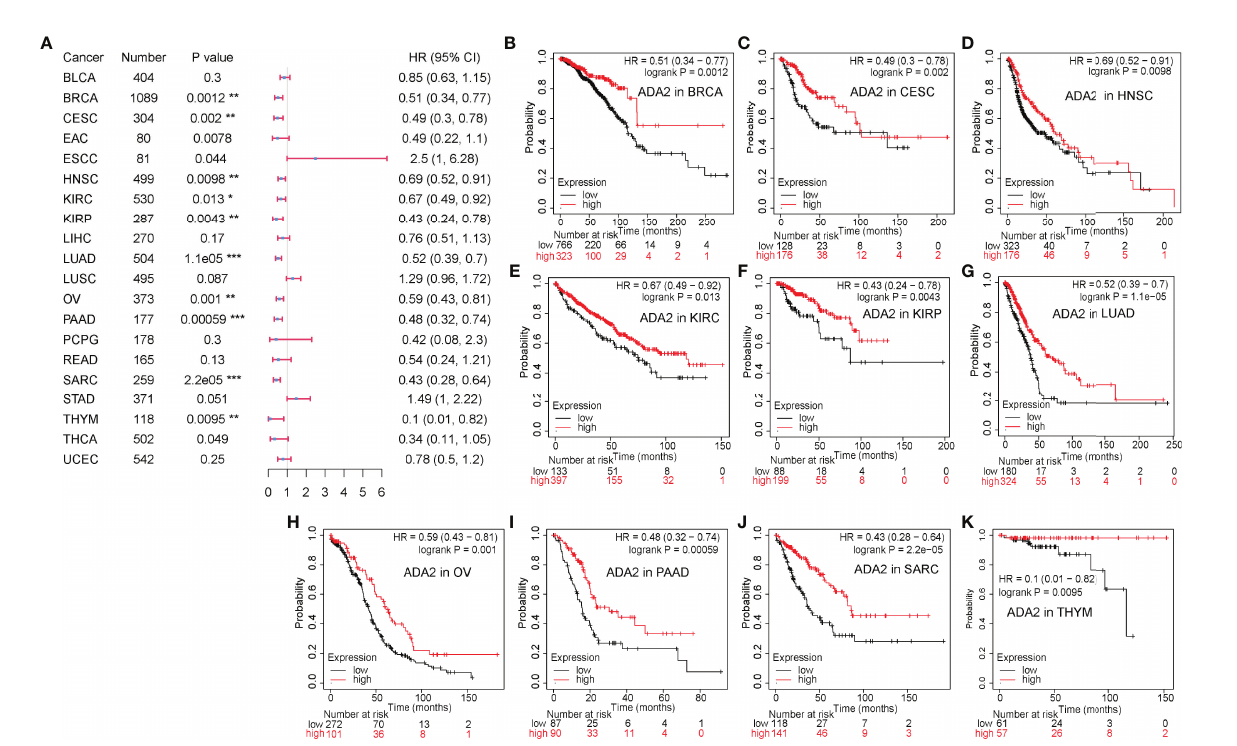
FIGURE 3 | Prognostic value of ADA2 in different cancers. (A) Forest plots showed the relation between ADA2 expression and OS of cancer patients. (B – K) Survival curves of BRCA, CESC, HNSC, KIRC, KIRP, LUAD, OV, PAAD, SARC, and THYM. *p < 0.05, **p < 0.01, ***p < 0.001. OS, overall survival; BRCA, breast invasive carcinoma; CESC, cervical squamous cell carcinoma and endocervical adenocarcinoma; HNSC, head and neck squamous cell carcinoma; KIRC, kidney renal clear cell carcinoma; KIRP, kidney renal papillary cell carcinoma; LUAD, lung adenocarcinoma; OV, ovarian serous cystadenocarcinoma; PAAD, pancreatic adenocarcinoma; SARC, sarcoma; THYM,